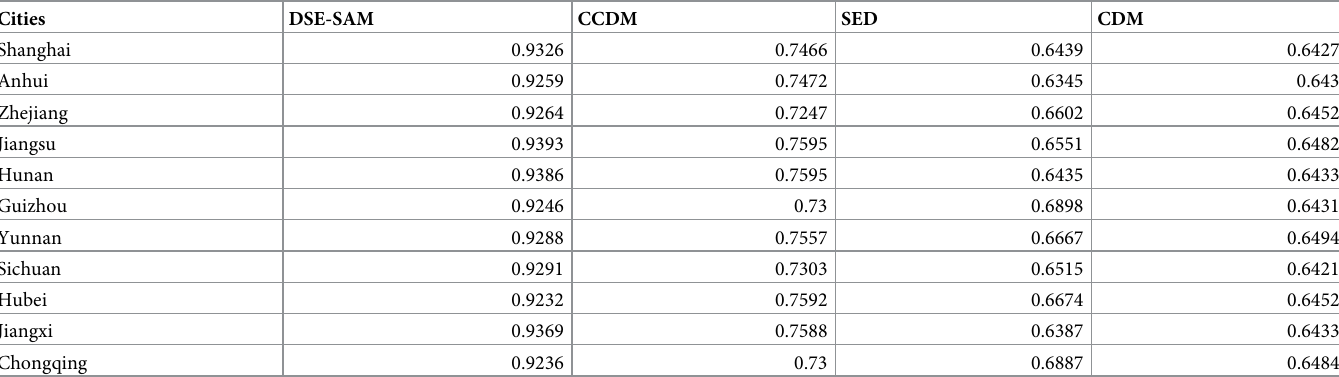
Table 7. Spatial autocorrelation analysis of various economic